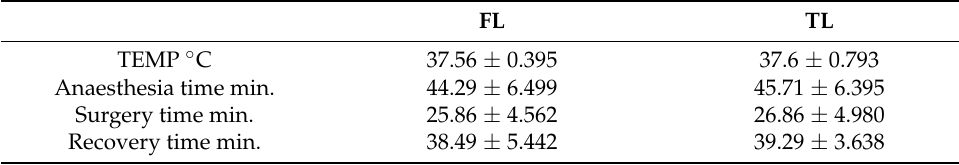
Table 1. Anaesthesia and surgery